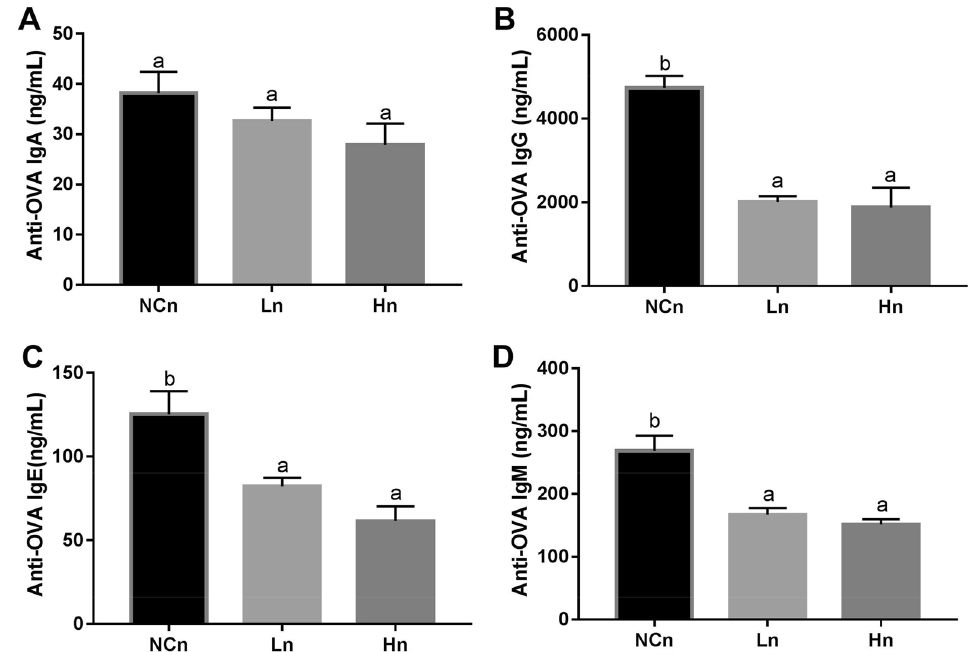
Figure 5. Concentrations of OVA-specific immunoglobulins in the serum of OVA-injected (s.c.) mice with additional intranasal administration. Levels of the OVA-specific immunoglobulins ( A ) IgA, ( B ) IgG, ( C ) IgE, and ( D ) IgM in serum. NCn mice gavaged with saline, negative control, Ln mice gavaged with low-dose LcSFB, Hn mice gavaged with high-dose LcSFB. Different superscript letters (a, b) indicate significant differences